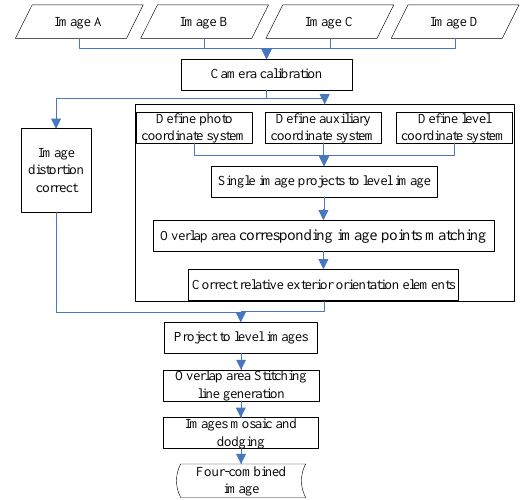
Figure 5. Self-calibration process of four-combined camera